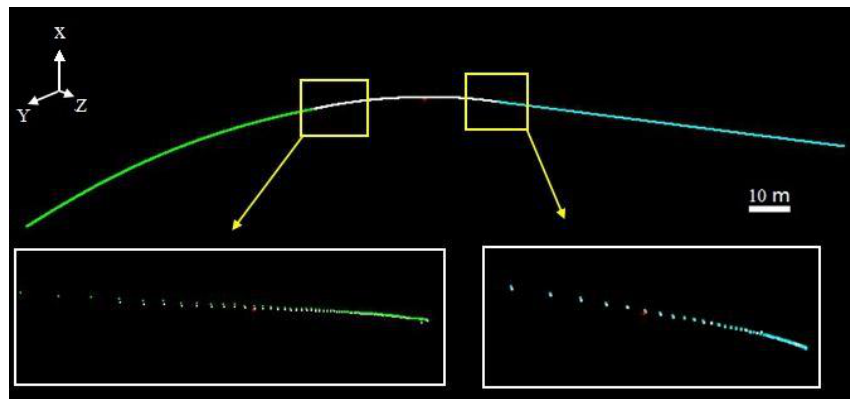
Figure 13. Central-axis fitting with global least squares